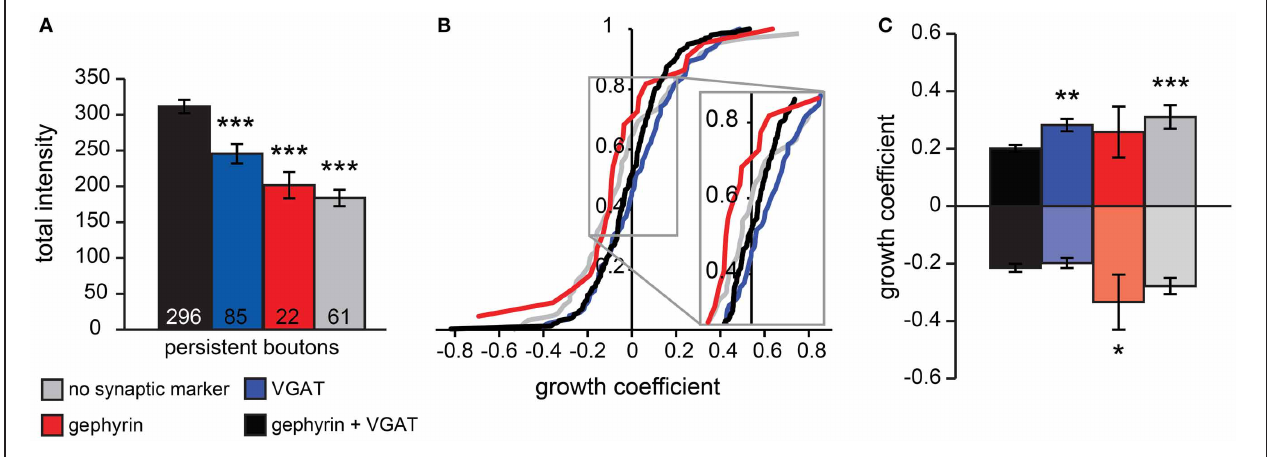
FIGURE 3 | Analysis of persistent bouton volumes. (A) Average volume of persistent boutons separated by synaptic markers (determined from post-hoc immunohistochemistry). Numbers at the bottom of bar graphs indicate the number of boutons in each group. (B) Cumulative distribution of growth coefficient values for persistent boutons separated by synaptic labeling. Inset